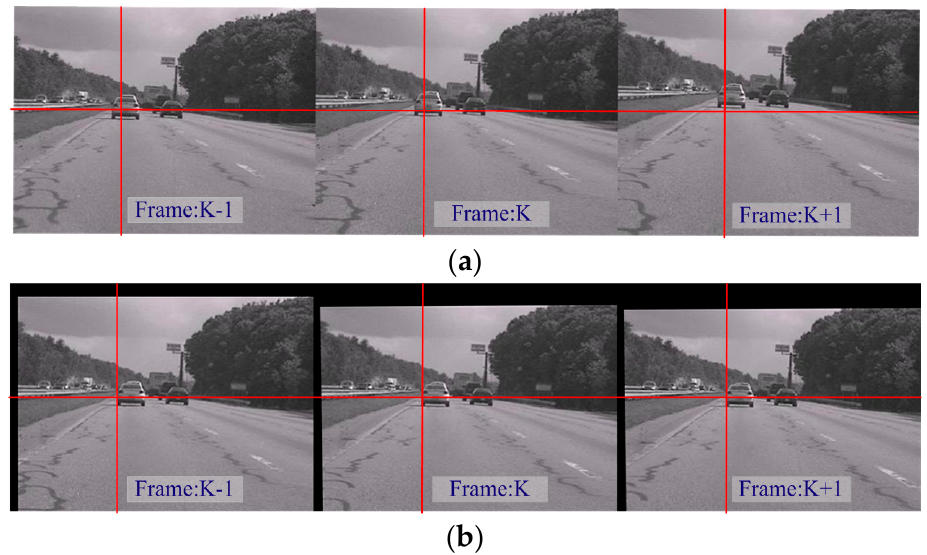
Figure 19. Frames in the original sequences ( a ) and stabilized sequences ( b ).